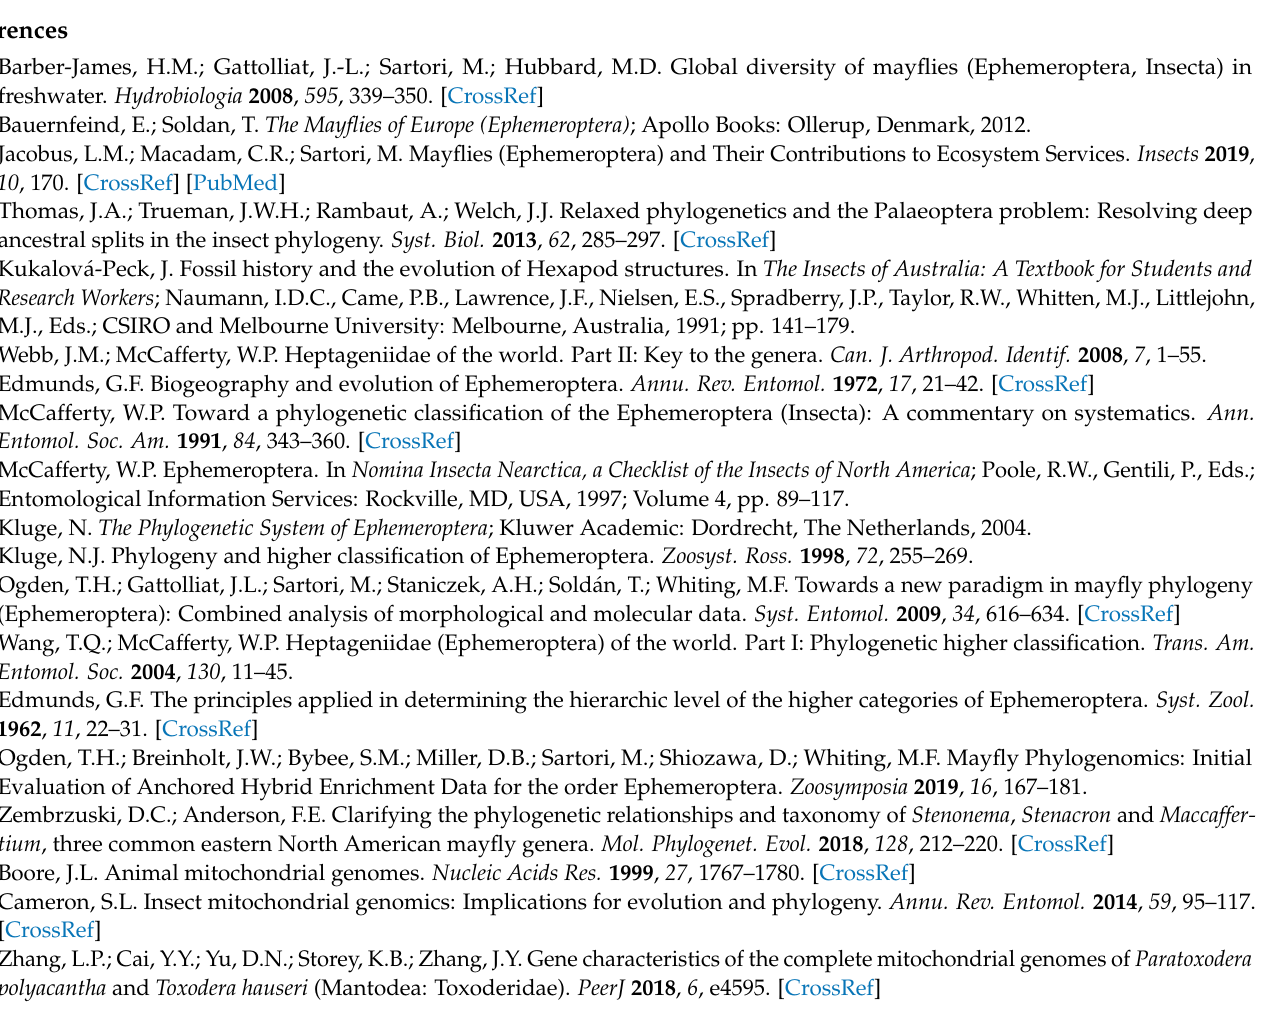
Table S5. The codon number and relative synonymous codon usage in mitochondrial PCGs; Table S6. Positive selection analysis of mitochondrial PCGs based on the branch